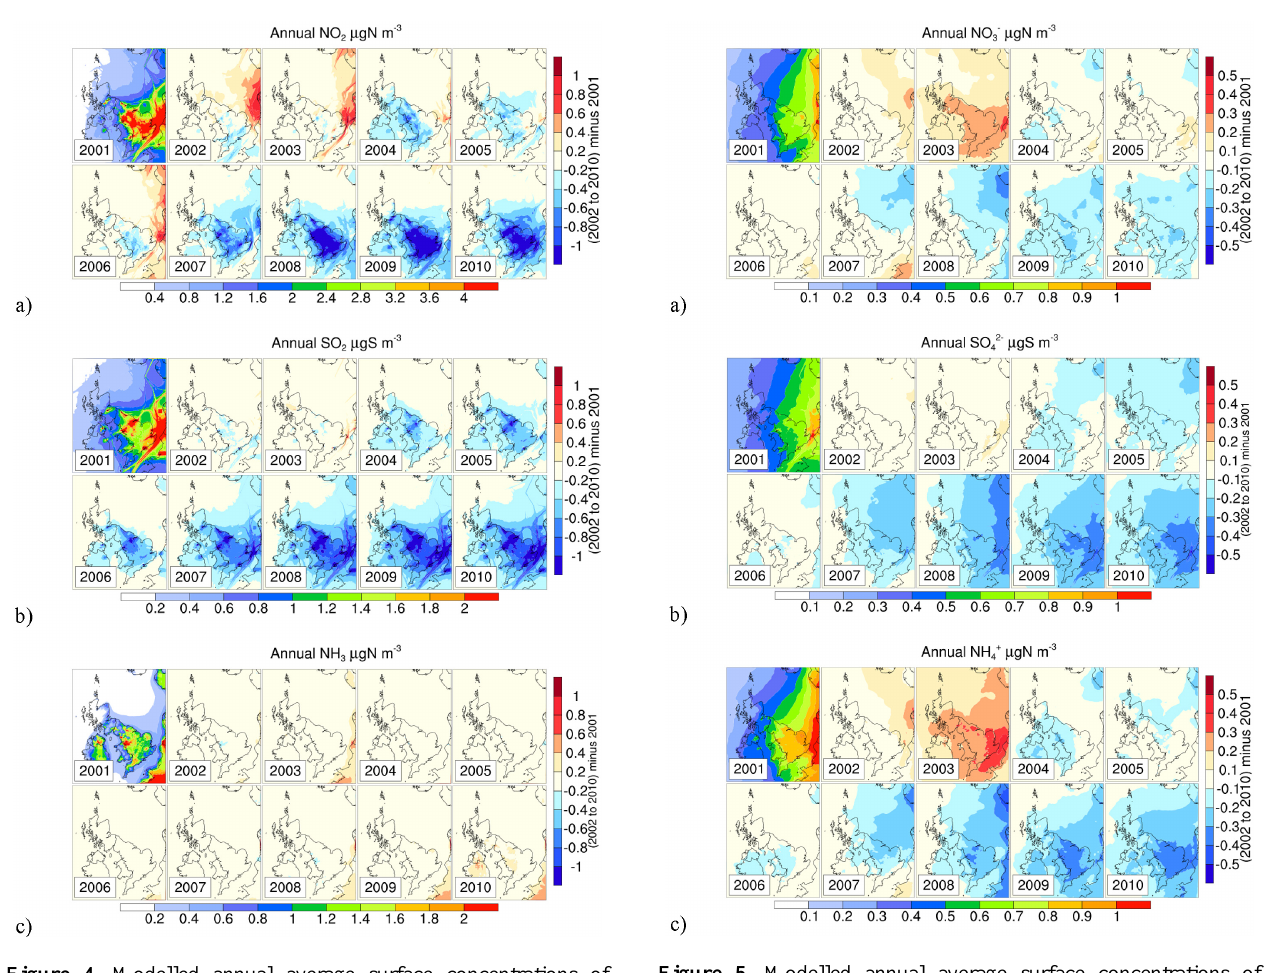
Figure 4. Modelled annual average surface concentrations of (a) NO 2 , (b) SO 2 and (c) NH 3 . The top left panel of each figure shows the concentrations in 2001 (horizontal scales in µgNm − 3 or µgSm − 3 , as relevant). The remaining panels illustrate the dif- ference in surface concentrations in each of years 2002 to 2010 compared with 2001 (vertical scales in µgNm − 3 or µgSm − 3 , as relevant).